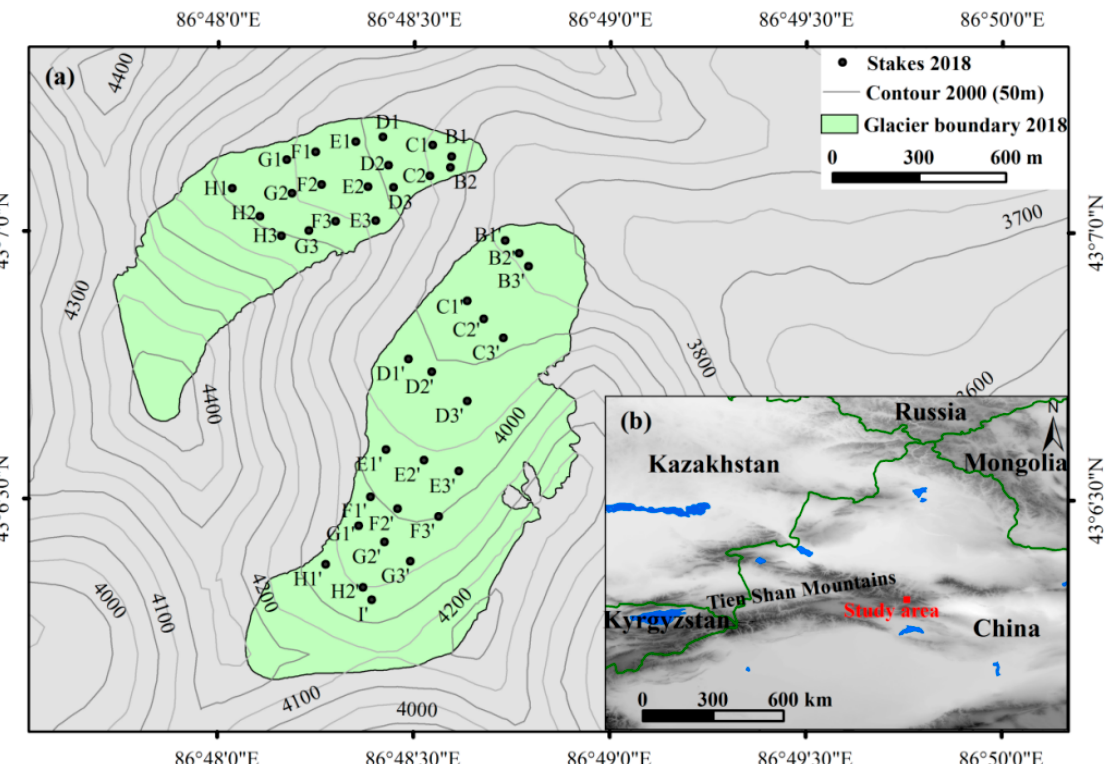
Figure 1. Study site description: ( a ) sketch map of the study including the locations of Urumqi Glacier No. 1 (UG1) and stakes in 2018. ( b ) Location map of Urumqi Glacier No. 1 in the eastern Tien Shan.